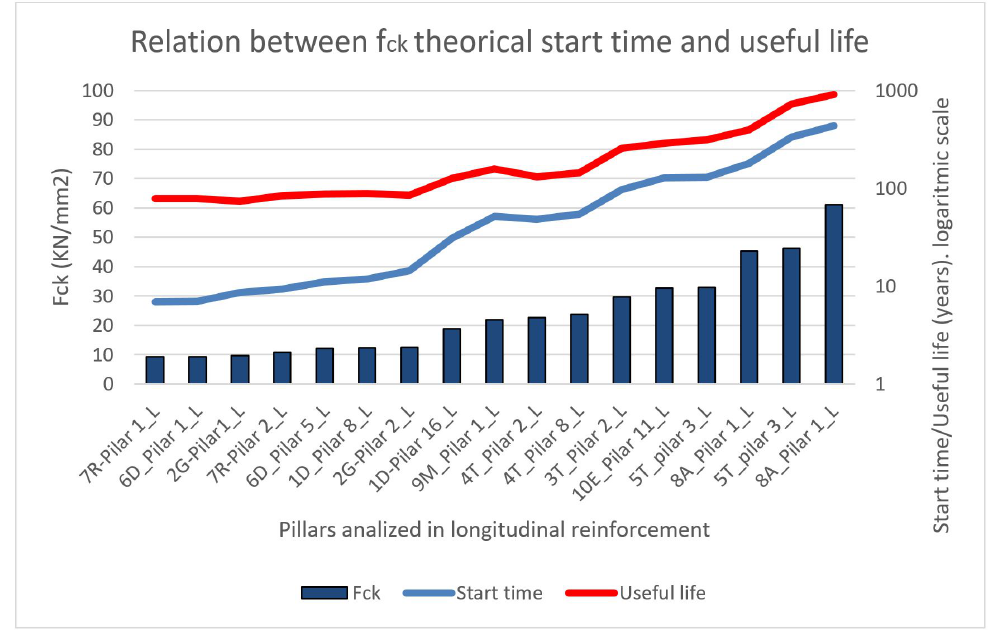
Figure 13. The relative study of F ck , theoretical start time and theoretical useful